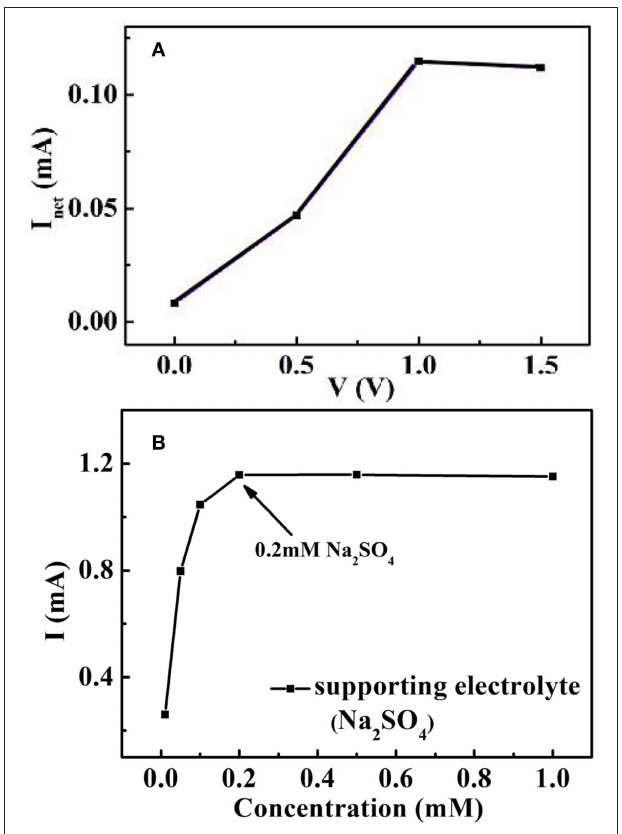
FIGURE 7 | Optimization of the real-time on-line sensing system: effect of (A) applied voltage and (B) supporting electrolyte concentration on photocurrent.